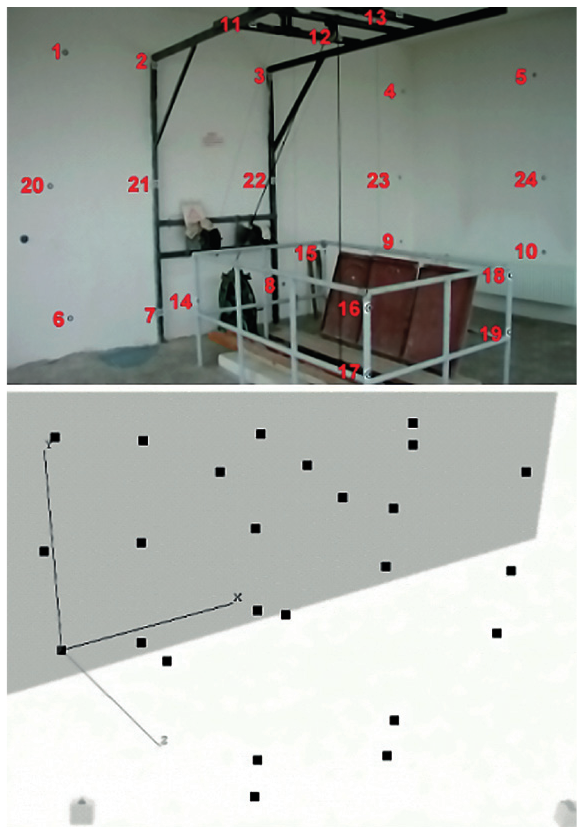
Fig. 2. 3D test IDGM field, 3D test field